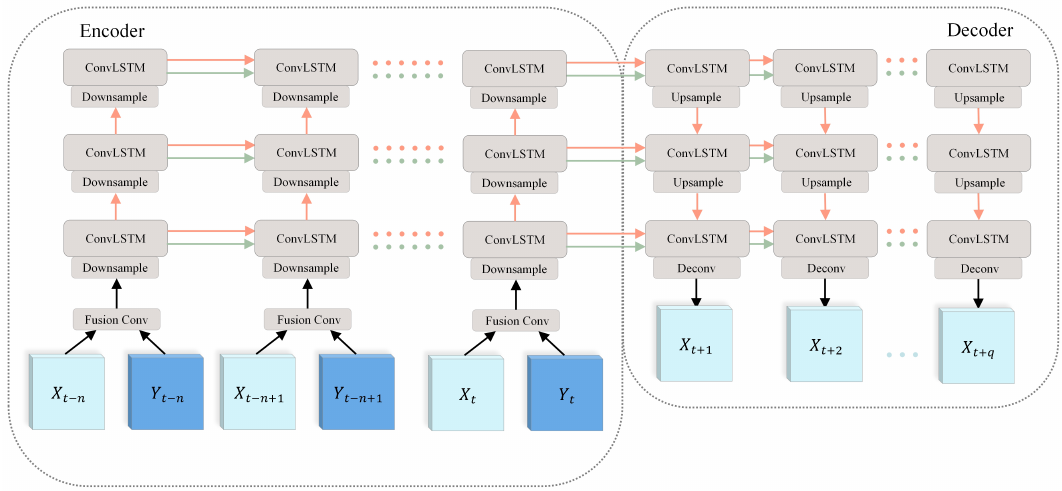
Figure 2. The dual-input early fusion ConvLSTM (EF-ConvLSTM) architecture. The two inputs are 3D tensors, defined as X t and Y t . EF-ConvLSTM forecasts the X t + 1 · · · X t + q in the future given the previous X t − n · · · X t and Y t − n · · · Y t including the current data.